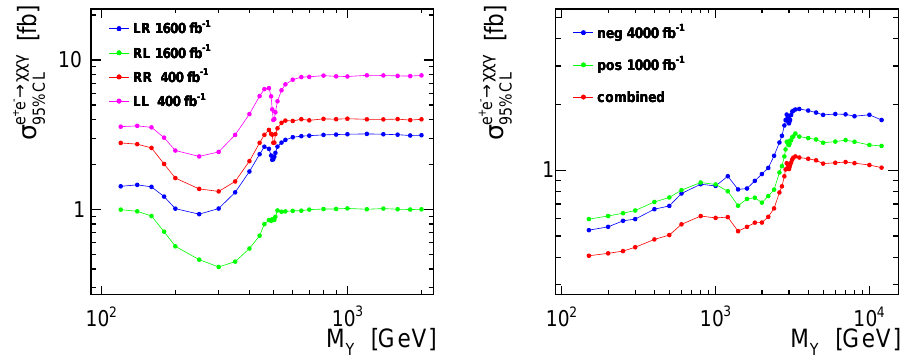
= 2.4 TeV at 3 TeV CLIC (right). Y